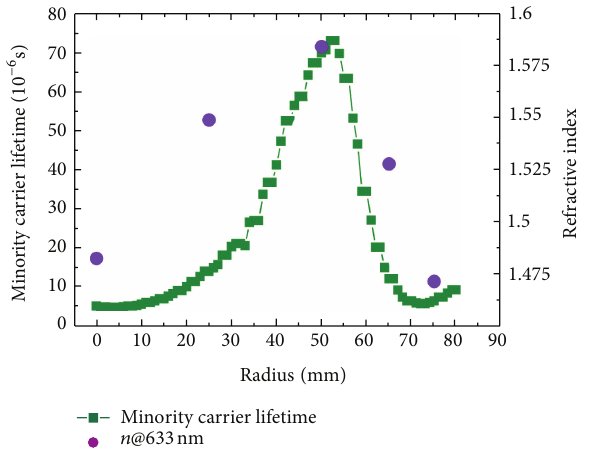
F 6: (a) e Si 2p �PS spectra of the aluminum oxide �lm sputtered at 1000W RF power as-deposited and aer 30min of C in N ambient which were detected at the etch annealing at 500 time of 780s. (b) Si 2p core-level spectrum �tted by using a synthetic ∘ 2 peak model for the aluminum oxide �lm sputtered at 1000W and aer